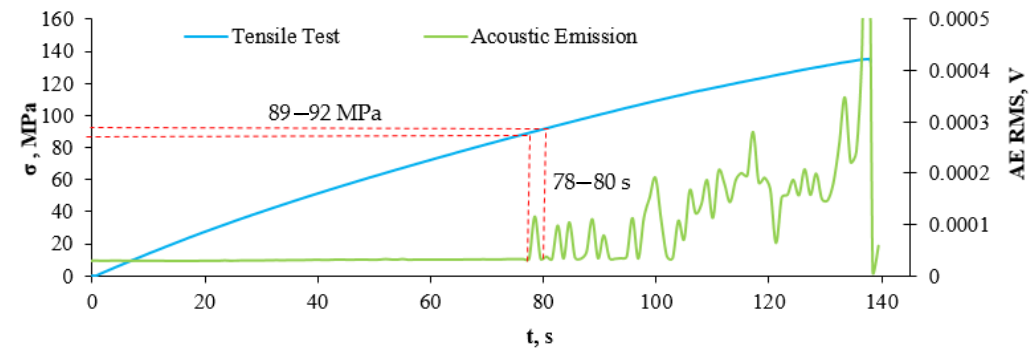
Figure 11. Graph of the value of the effective acoustic emission signal as a function of time, plotted on the stress-strain graph for a composite without recyclate.